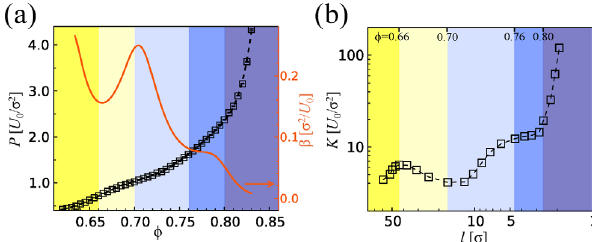
FIG. 3. (a) The equation of state P ð ϕ Þ (squares) and the compressibility β (curve). (b) Bulk modulus K ð l Þ